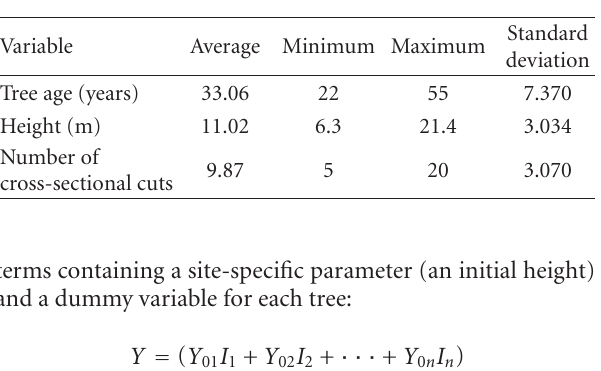
Table 1: Characteristics of the stem analyses data coming from the 62 fallen trees used for modelling height